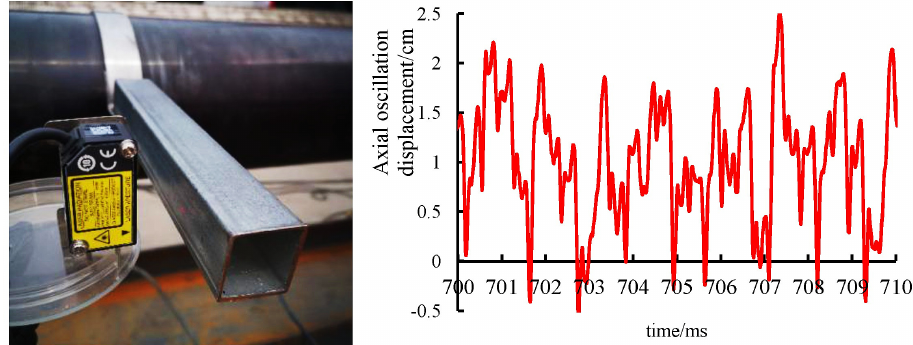
Figure 11. Position of the laser displacement sensor and curve of the impact displacement.